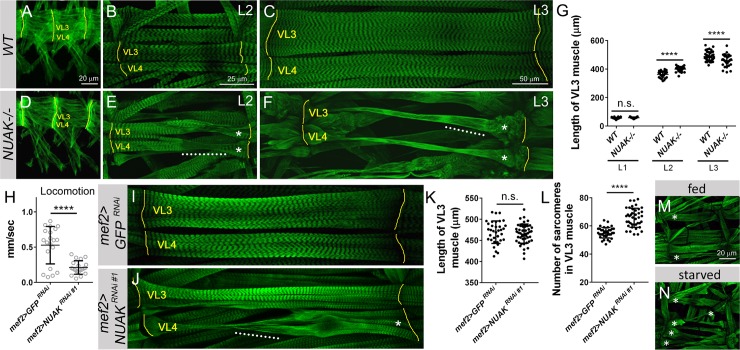
Progressive muscle degeneration is prevalent upon a loss of NUAK.(A-F) Visualization of muscles VL3 and VL4 (green) throughout embryonic and larval development. Muscle attachment sites at the hemisegment borders are denoted with yellow lines. (A,D) Two hemisegments of the embryonic musculature in stage 17 embryos are immunostained with anti-MHC. (B,C,E,F) Phalloidin-labeled WT or NUAK-/- larvae. (A) The normal muscle pattern in a WT embryo. (B,C) WT muscles are rectangular and increase in size from the L2 (B) to the L3 (C) stage. (D) The final pattern of muscles in homozygous NUAK-/- embryos appears WT. (E,F) Muscle defects, including a loss of sarcomeric patterning and thinning muscles (white dotted line) in NUAK-/- are apparent in L2 individuals (E) and progressively deteriorate during the L3 stage (F). Asterisks indicate affected muscles. (G) Scatter plot showing the length of individual VL3 muscles during larval development upon loss of NUAK. (H-N) Knockdown of NUAK via expression of a weaker RNAi line in muscle tissue (mef2>UAS-NUAK
RNAi #1). (H) Scatter plot reveals a decrease in locomotor ability upon NUAK RNAi compared to GFP RNAi controls. (I,J) Muscles VL3 and VL4 (green) are not affected in GFP RNAi control larvae (I), but exhibit variable defects upon NUAK RNAi knockdown (J, white dotted lines). Asterisks indicate affected muscles. (K,L) Scatter plots indicate that the length of VL3 muscles is not altered (K), but sarcomere number is increased, upon induction of NUAK RNAi (L). (M,N) One hemisegment of the larval musculature in mef2>UAS-NUAK
RNAi #1 larvae under fed (M) or growth-inhibited (N) conditions (n = 6 for each). The increase in abnormal phenotypes (*) when growth is stalled indicates that muscle use is the primary cause of tissue degeneration. Mean +/- SD. (****p<0.001; n.s., not significant).